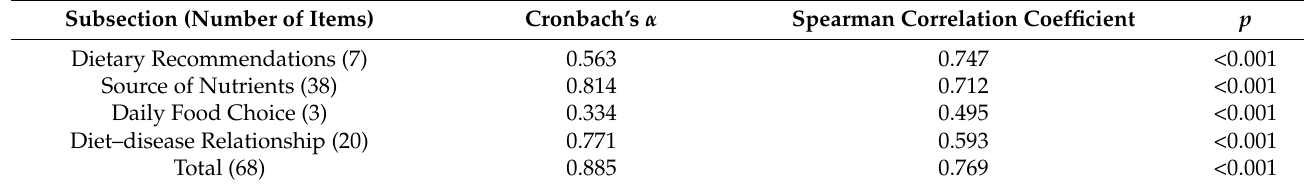
Table 3. Internal consistency and test-retest reliability of the revised